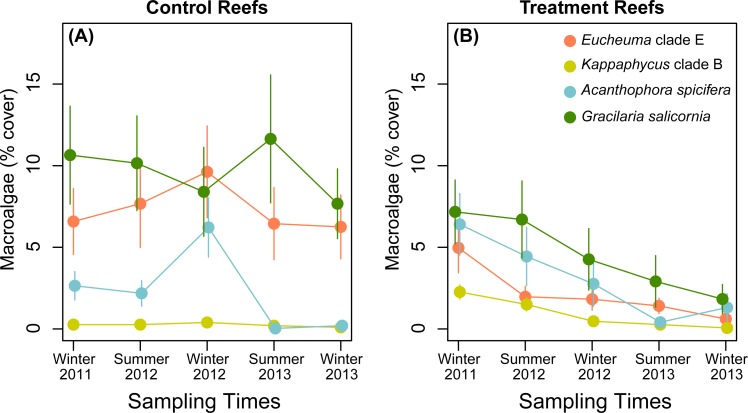
Percent cover for invasive macroalgae species through time.(A) control reefs and (B) treatment reefs. Values are mean ± SE; n = 24 (control reefs) and n = 26–27 (treatment reefs) for each sampling time.